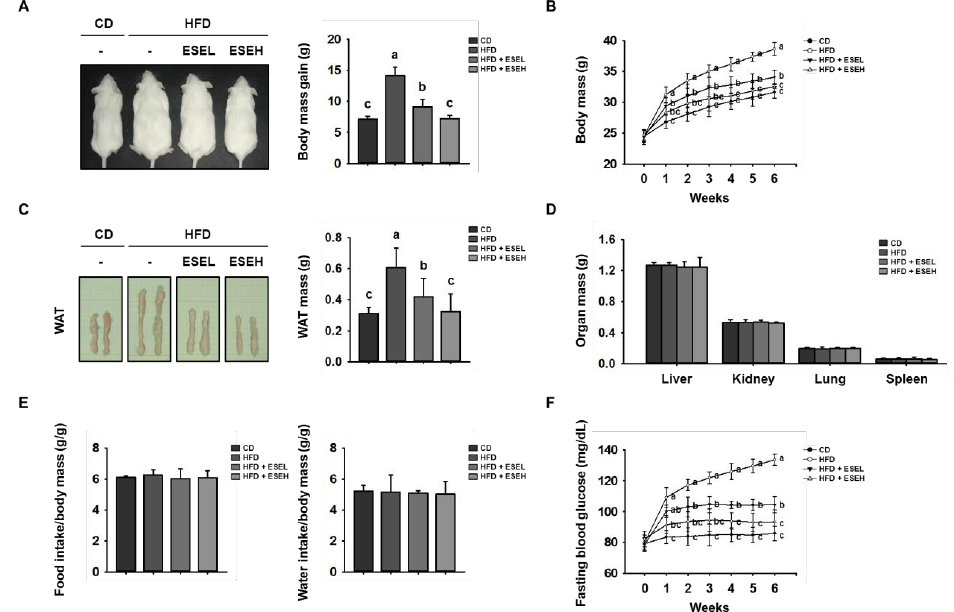
Figure 1. Effects of Ecklonia stolonifera extract (ESE) on obesity in high-fat diet (HFD)-induced obese mice. ( A ) Representative images of mice and their body mass gain over 6 weeks. ( B ) Body mass, measured regularly during the 6 weeks of ESE treatment. ( C ) Representative images and the mass of white adipose tissue (WAT) depots. ( D ) Masses of other organs. ( E ) Food and water intake per unit body mass. ( F ) Fasting blood glucose, measured weekly over the 6 weeks of ESE treatment. Data are expressed as means ± SDs ( n = 8). Values with different letters are significantly different: p < 0.05 (a > b > c).